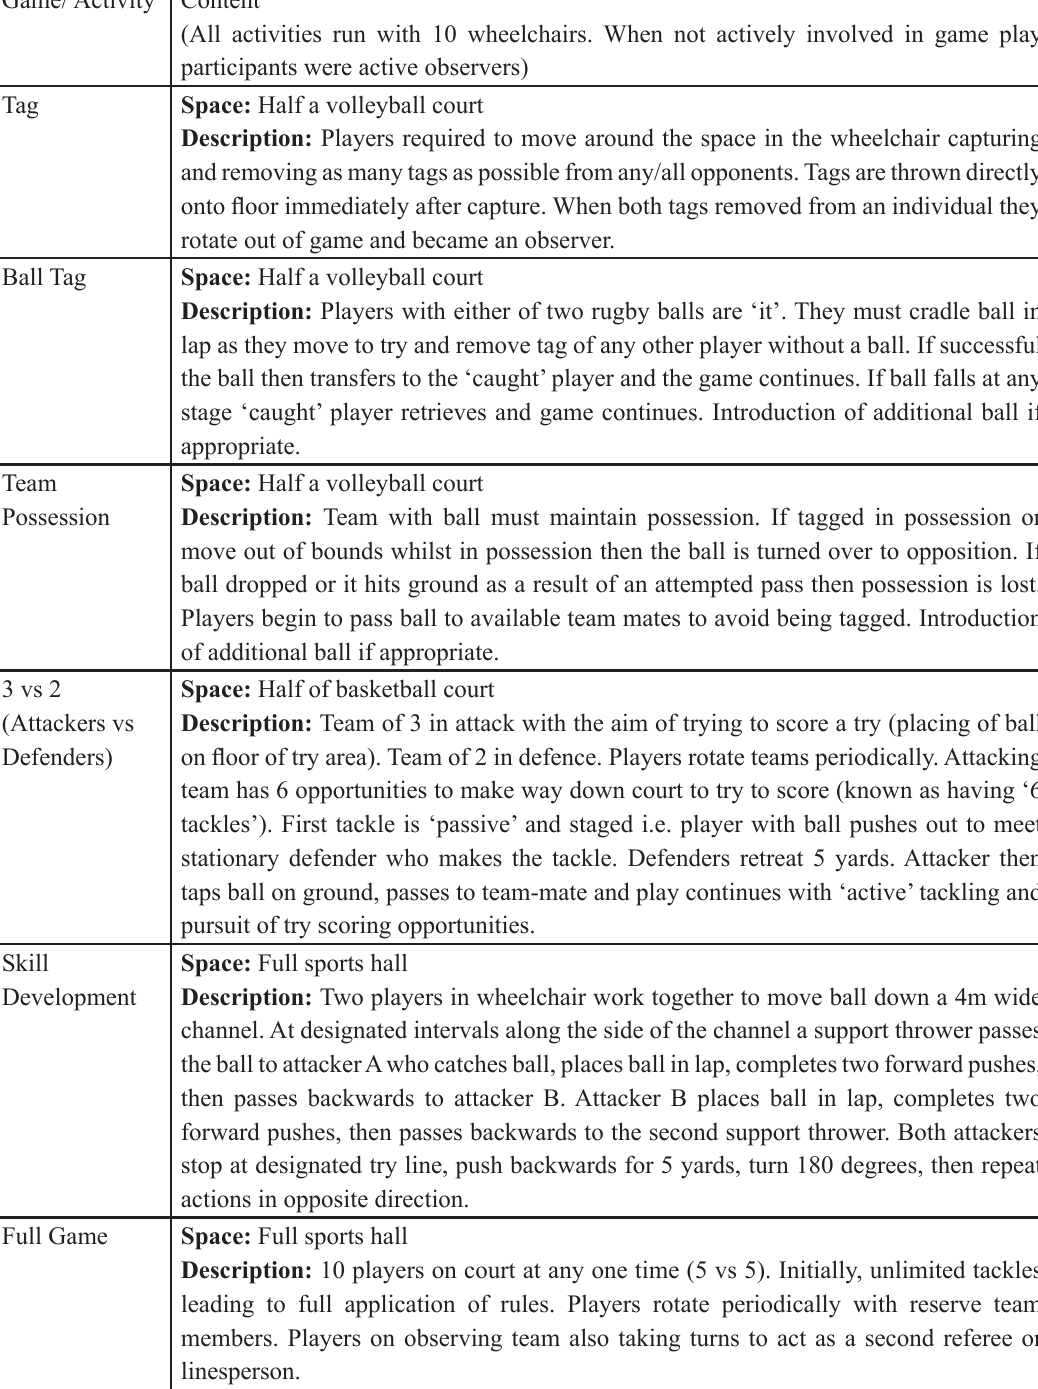
Table 1: Overview of Session